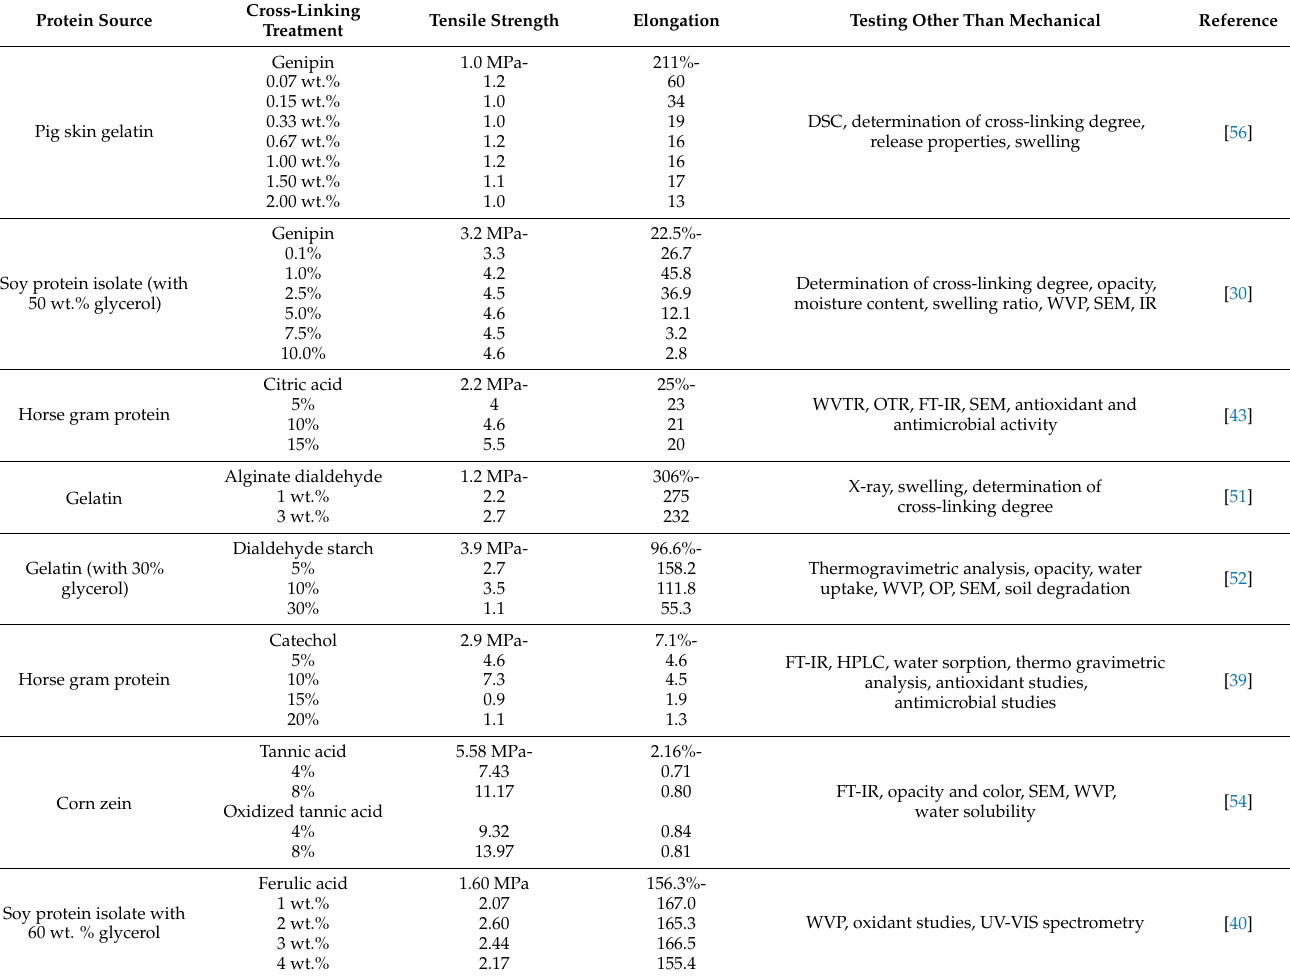
Table A1. Summary of mechanical properties of protein-based films after cross-linking modification. Extended data, including error intervals and a more detailed description of methods, are provided in the respective